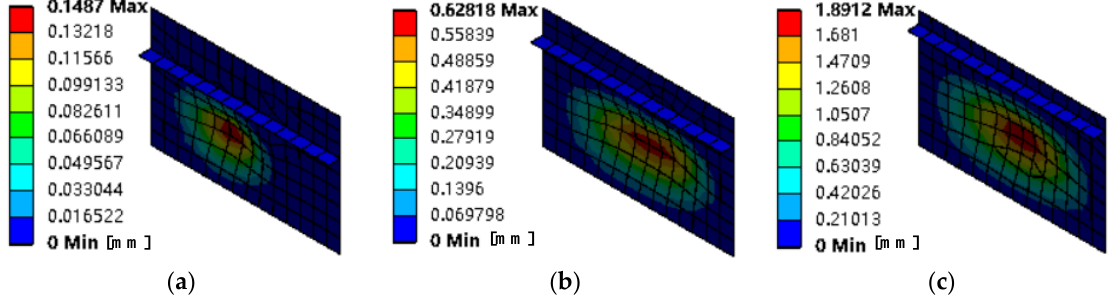
Figure 8. Response diagram of stiffened plate with variable distance. ( a ) Located at 100 mm. ( b ) Located at 150 mm. ( c ) Located at 200 mm.